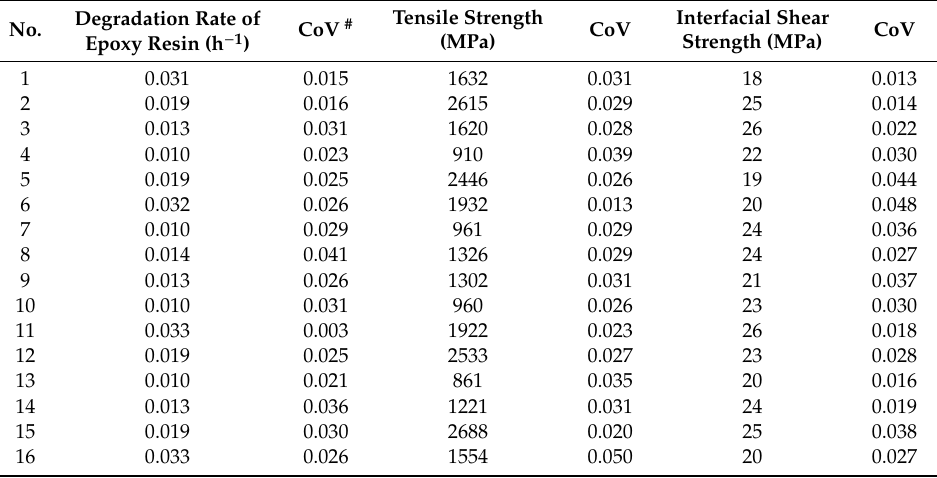
Table 3. Degradation rate of epoxy resin, tensile strength, and interfacial shear